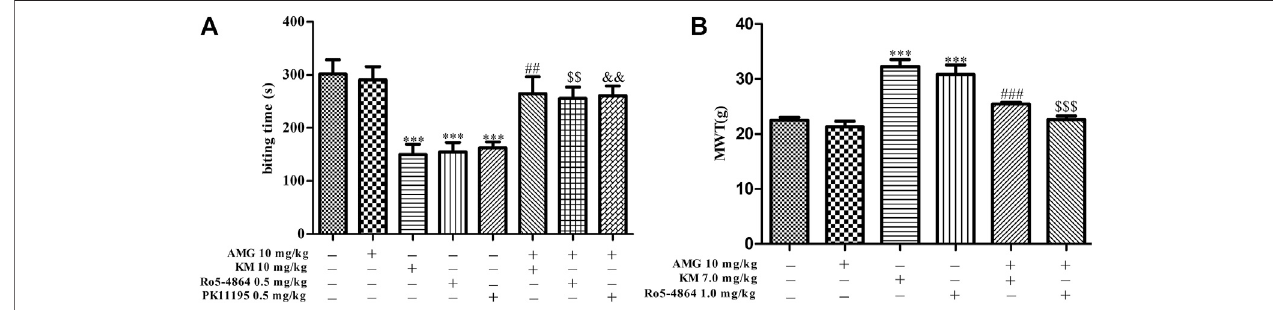
FIGURE2| Koumine-mediatedanalgesiceffects invivo canbepreventedbyAMG. (A) ApplicationofAMG(10 mg/kg,i.p.)40 minbefores.c.injectionoftheTSPO ligandabolishedtheanti-in fl ammatory paineffects intheformalintestinmice. (B) ApplicationofAMG(10 mg/kg,i.p.)40 minbeforethekoumine(s.c.)orRo5-4864(i.p.) injection abolished the anti-neuropathic pain effects in the CCI neuropathic pain model. Abbreviations: AMG, aminoglutethimide, KM, koumine, MWT, mechanical withdrawalthreshold.Dataarepresentedasthemean ± SEM,*** p < 0.001vs.thecorrespondingvehiclegroup.Intheformalintest, ## p < 0.01versusthe10 mg/kg KMgroup, $$ p < 0.01versusthe0.5 mg/kgRo5-4864group, && p < 0.01versusthe0.5 mg/kgPK11195group.IntheCCIneuropathicpainmodel, ### p < 0.001versus the 7 mg/kg KM group, $$$ p < 0.001 versus the 1.0 mg/kg Ro5-4864 group. The comparison between the two groups was analyzed by independent samples t -test, and multiple comparisons were compared by one-way ANOVA followed by LSD post hoc test. Each group consisted of 6 – 10